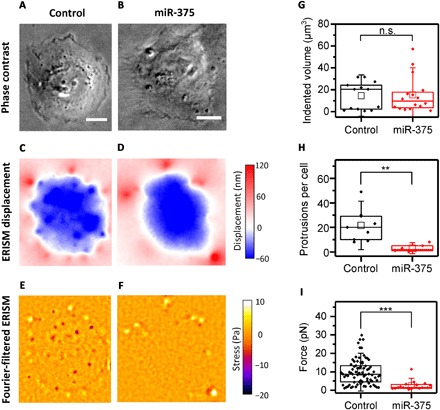
Impact of overexpression of the miR-375 on the mechanical activity of UM-SCC-1 cells.(A and B) Phase-contrast, (C and D) ERISM, and (E and F) Fourier-filtered ERISM images of representative UM-SCC-1 control cell (left column) and miR-375–overexpressing cell (right column). (G) Comparison of total volume by which cells indent into the ERISM substrate. Control, n = 13 cells; miR-375, n = 16 cells. As data in groups were not normally distributed, groups were compared using the Mann-Whitney U test (P = 0.983). (H) Comparison of the number of protruding invadopodia formed per cell (mixed population of mature and immature invadopodia). Control, n = 9 cells; miR-375, n = 6 cells. Two-sample t test (P = 0.005). (I) Comparison of force exerted by invadopodia from both cell types. Control, n = 106 invadopodia from eight cells; miR-375, n = 47 invadopodia from three cells. As data in groups were not normally distributed, groups were compared using the Mann-Whitney U test (P = 1.41 × 10−6). Statistical tests: not significant (n.s.), P > 0.05; **P < 0.01; ***P < 0.001. Scale bars, 20 μm.